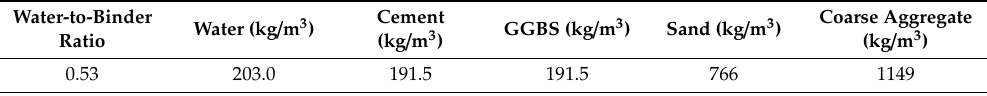
Table 1. Mix proportion of